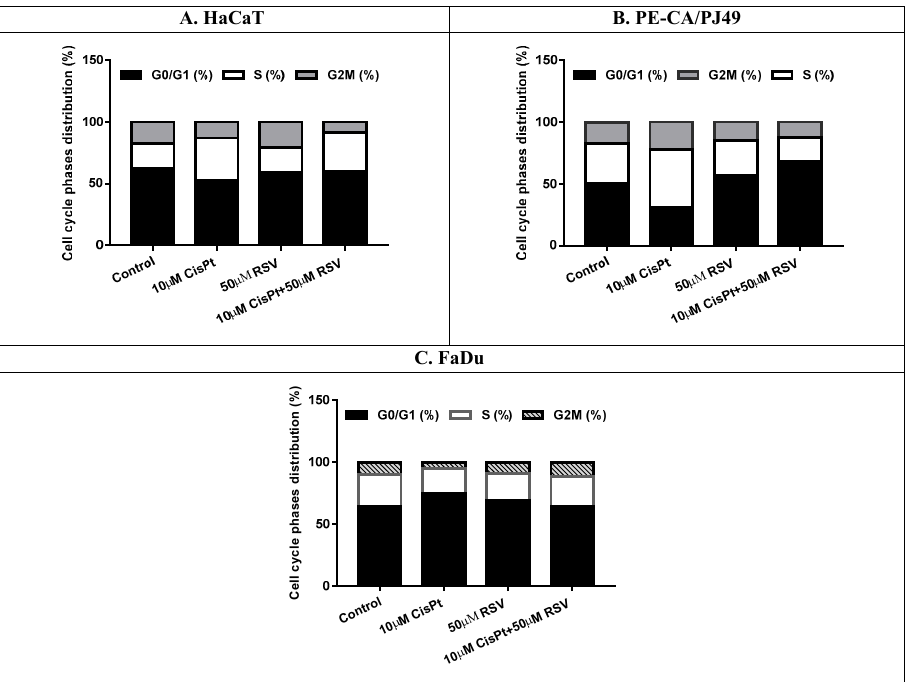
Figure 6. Cell cycle phase distribution (%) in normal HaCaT cells ( A ) and tumor cells: PE/CA-PJ49 ( B ) and FaDu ( C ), after treatment with CisPt and/or